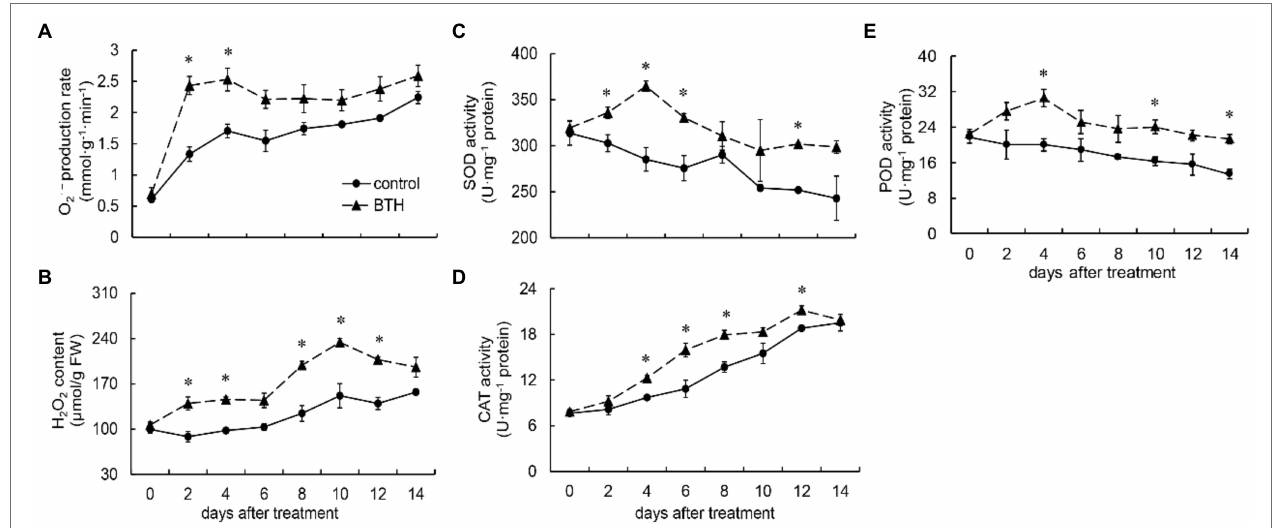
Different letters indicate significant differences between the BTH-treated and control fruit (p < 0.05).